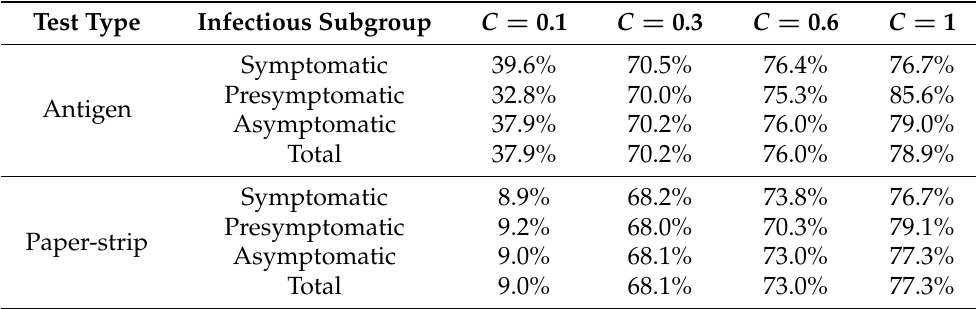
Table 3. Percent reduction in daily incidence transmission for antigen and paper-strip tests at various daily testing capacities compared to daily incidence transmission for a RT-PCR test administered at C = 0.1 testing capacity per